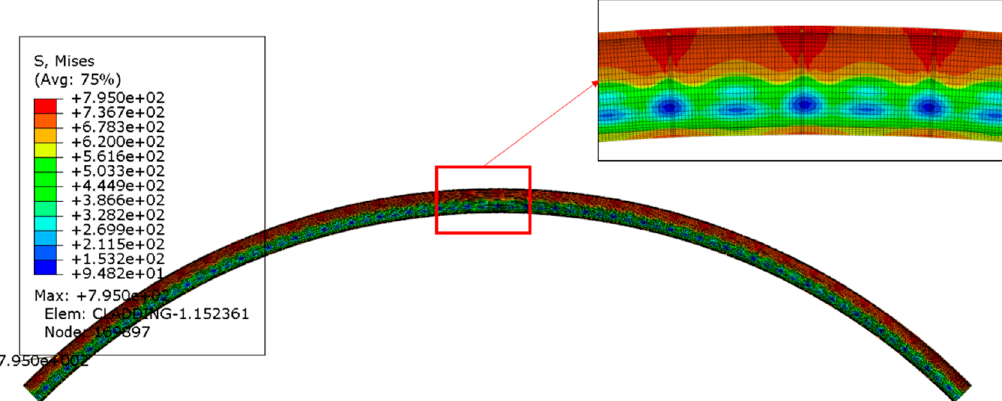
Figure 7. Deformed shape and stress distribution of cladding (fully de-bonded interface).